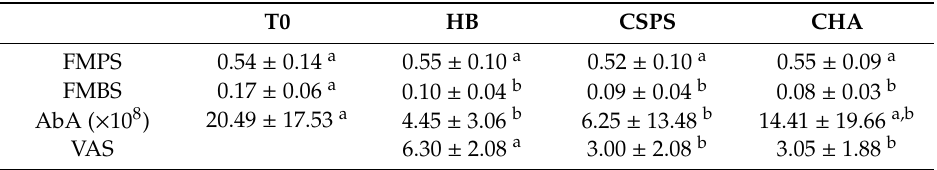
Table 1. Comparison between groups. All values are expressed as means and standard deviations. T0